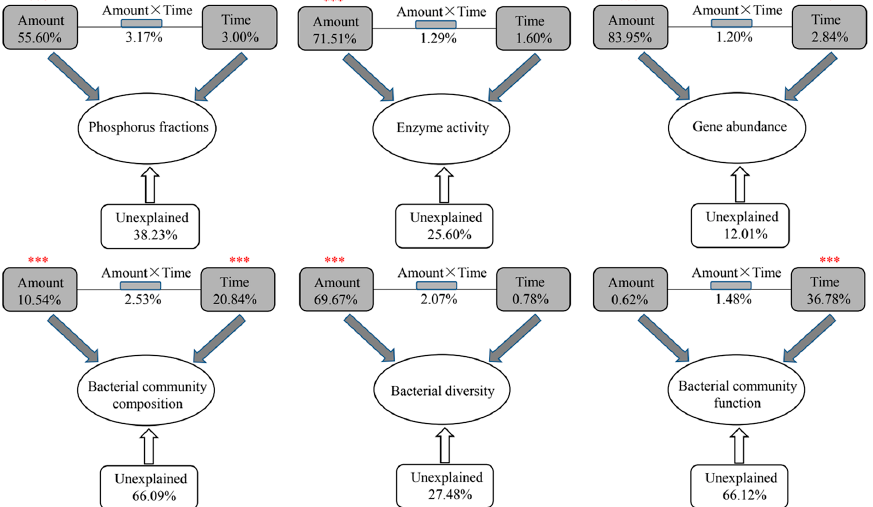
Figure 1. Permutational multivariate analysis of variance (PERMANOVA) showing the effects of TiO 2 NP addition amounts and exposure times on phosphorus fractions, enzyme activity, phosphorus-cycling-related gene abundance, composition, diversity, and function of the bacterial community in sediments. Asterisks represent significance (*, p < 0.05; ***, p < 0.001).